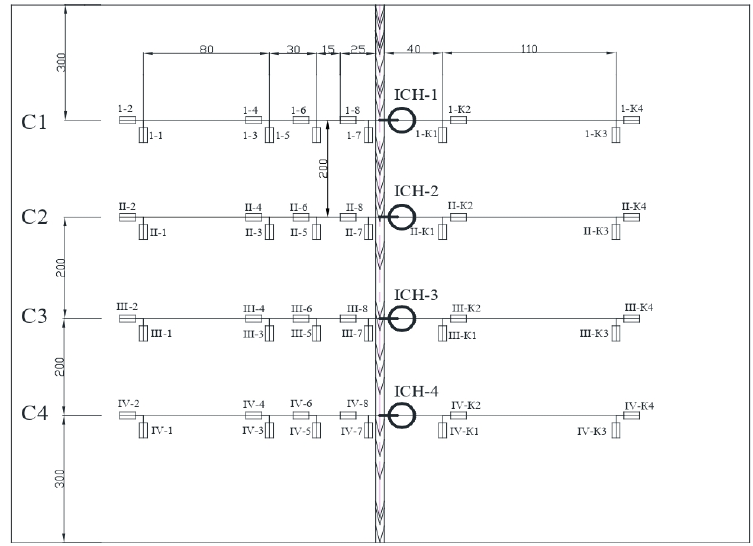
Figure 3. Placement of strain gauges and dial indicators in the field joint zone.